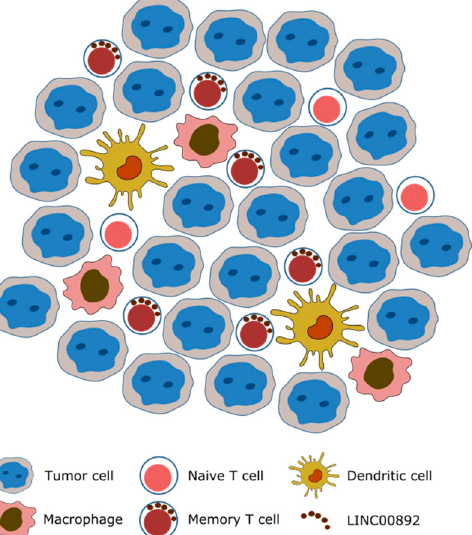
Figure 8. Possible use of LINC00892 as a biomarker for memory T cells: The figure proposes that in the analysis of a follicular lymphoma tissue, LINC00892 expression by ISH could help differentiate memory T cells from naïve T cells.